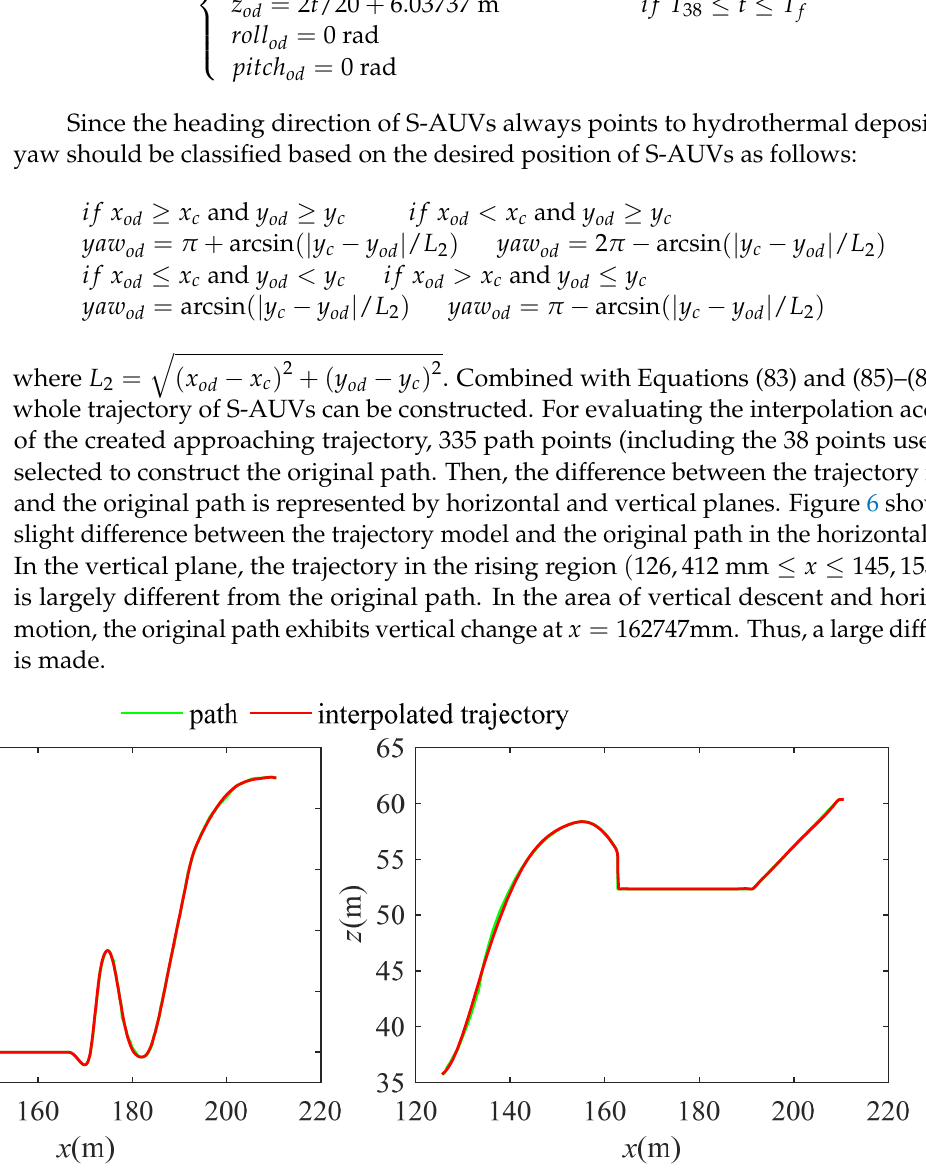
Figure 6. Comparison of trajectory models and paths in horizontal and vertical planes.